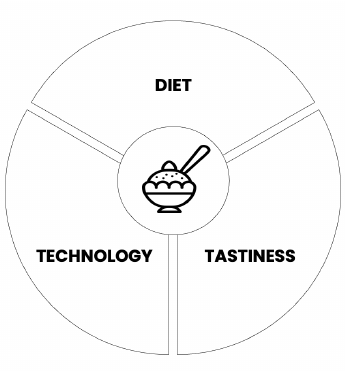
Figure 2. Aspects of a dish to consider while replacing ingredients.